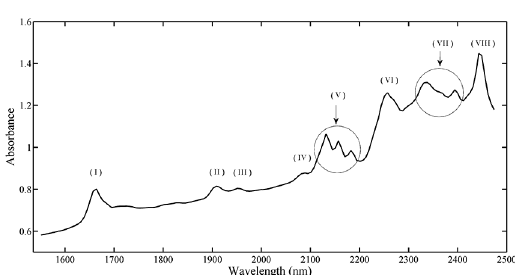
Figure 4. Mean NIR spectrum of PET samples before exposure to the chemical